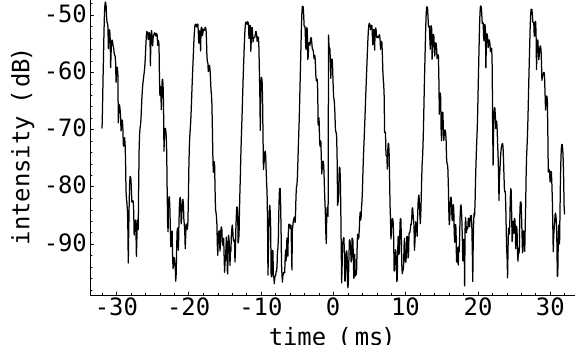
FIG. 3. (Color) Synchrotron sidebands of a single-bunch 205 mA beam about a high harmonic for several values of the harmonic-cavity voltage; the top trace is near zero, and the sec- ond to the bottom is near the optimum for stretching. The short- bunch trace at the top shows quadrupole-mode lines at 22 kHz offset, and the long-bunch traces show broadened lines that fill the 10–15 kHz range and its harmonics.